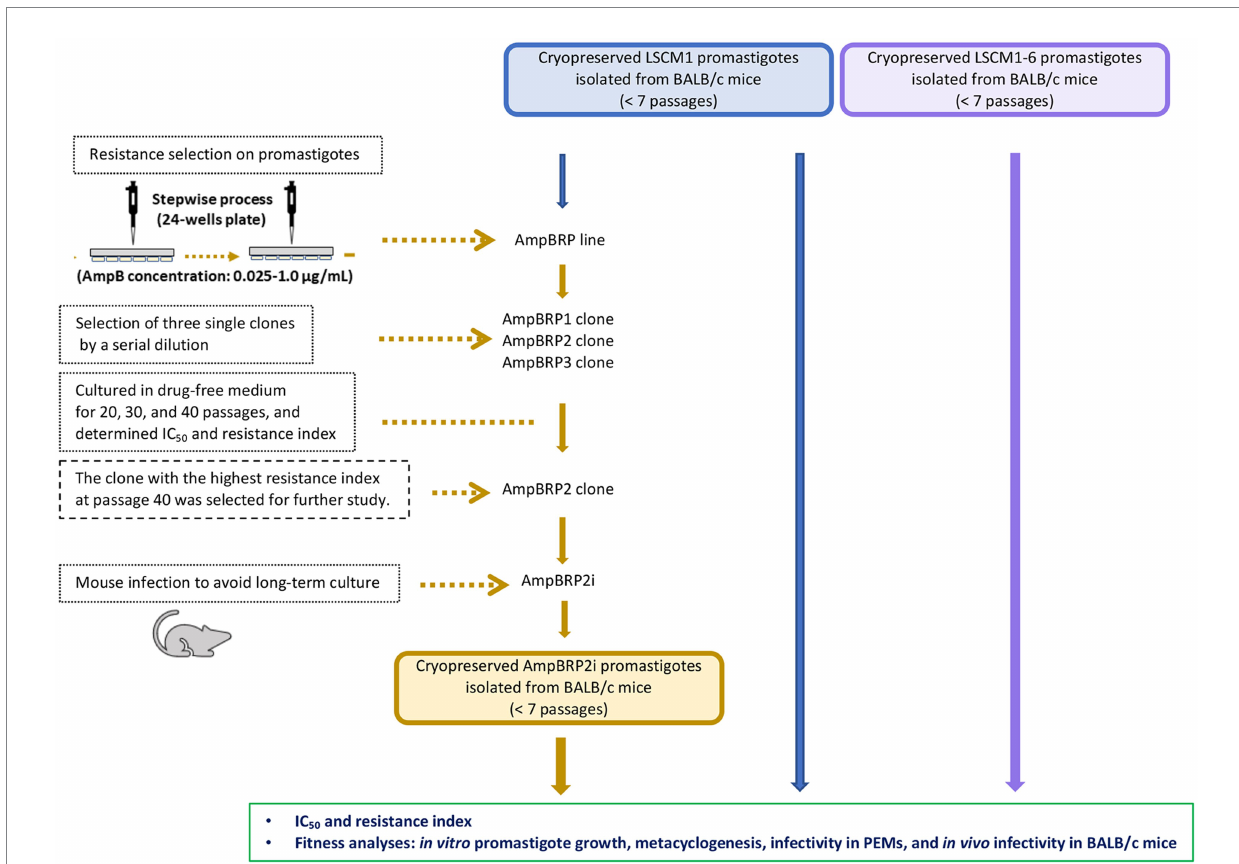
FIGURE 1 Schematic diagram of resistance selection for an AmpB-resistant clone on promastigotes and an overview of the comparative fitness of the LSCM1, AmpB-resistant clone, and